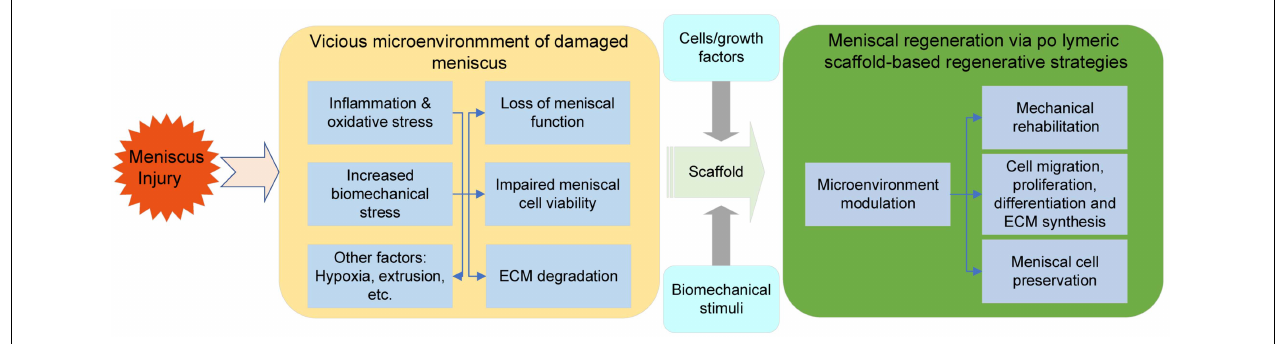
FIGURE 6 | Hostile microenvironment of damaged meniscal tissue and the regenerative process initiated via polymeric